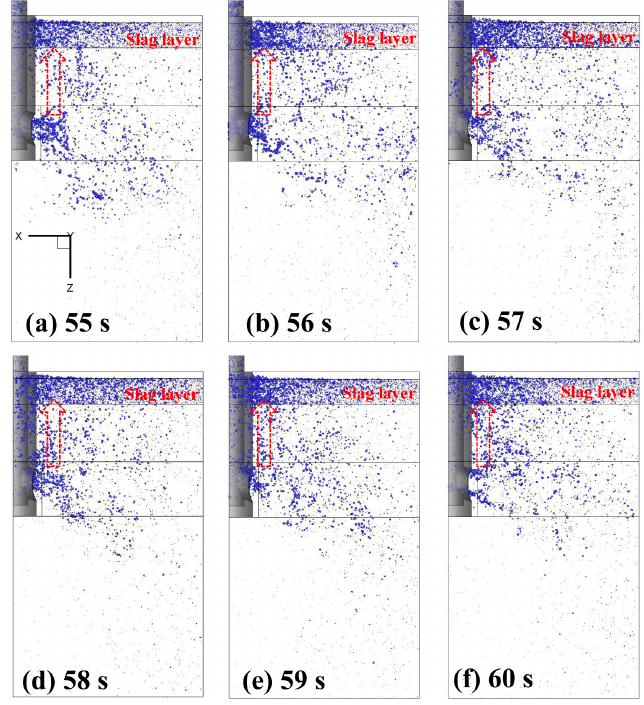
Figure 5. Predicted bubble distributions after ( a ) 55 s, ( b ) 56 s, ( c ) 57 s, ( d ) 58 s, ( e ) 59 s, and ( f ) 60